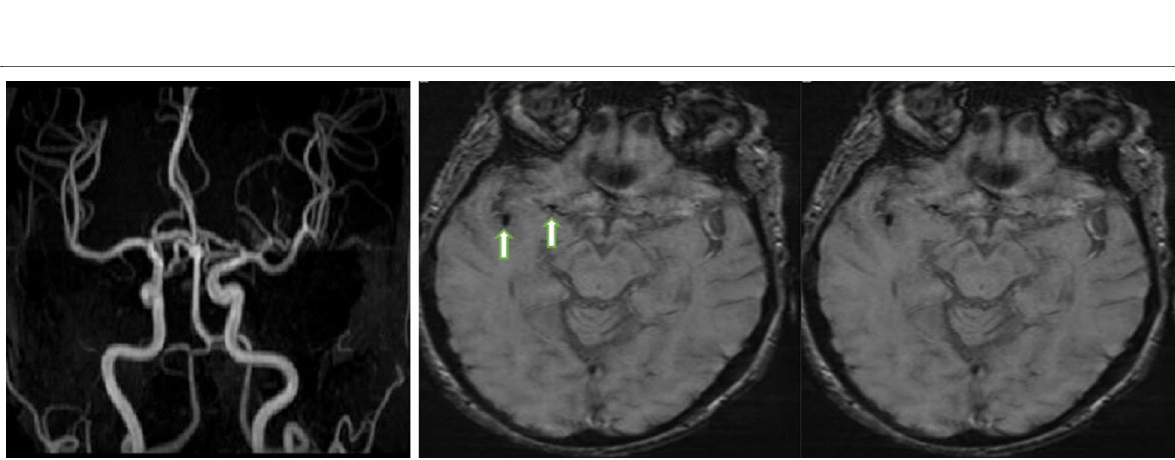
Fig. 2 An 52-year-old man, MRA a reveals normal filling of cerebra vessels at both sides, SWI b shows two susceptibility vessel sign at M1 and M2 segments of right